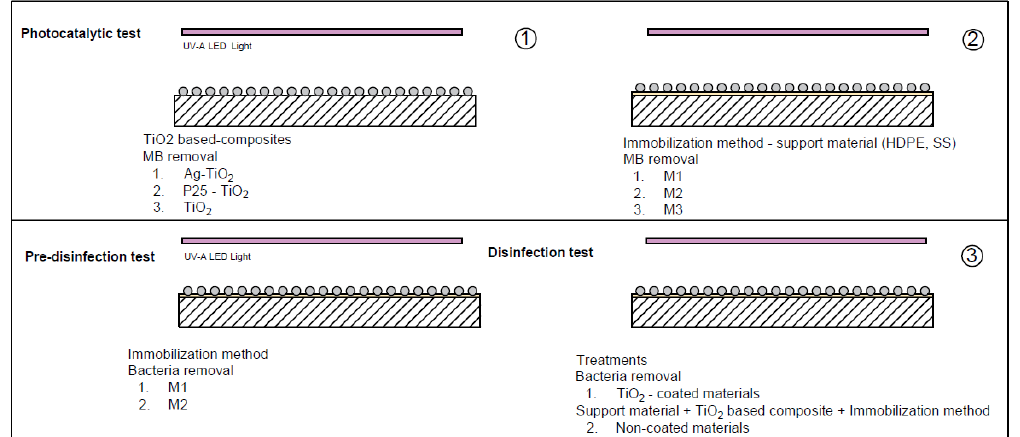
Figure 1. Experimental design scheme of each study stages. ① Evaluation of TiO 2 based-composites in the removal of MB. ② Evaluation of immobilization method on study support materials in the removal of MB. ③ Pre-disinfection test to select the most efficient immobilization method for bacteria reduction. Disinfection test to evaluate treatments (TiO 2 coated materials and non-coated materials) for bacterial removal.